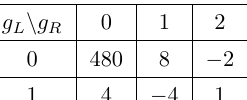
Table 15 . The refined GV numbers n g L ,g R the integer basis.